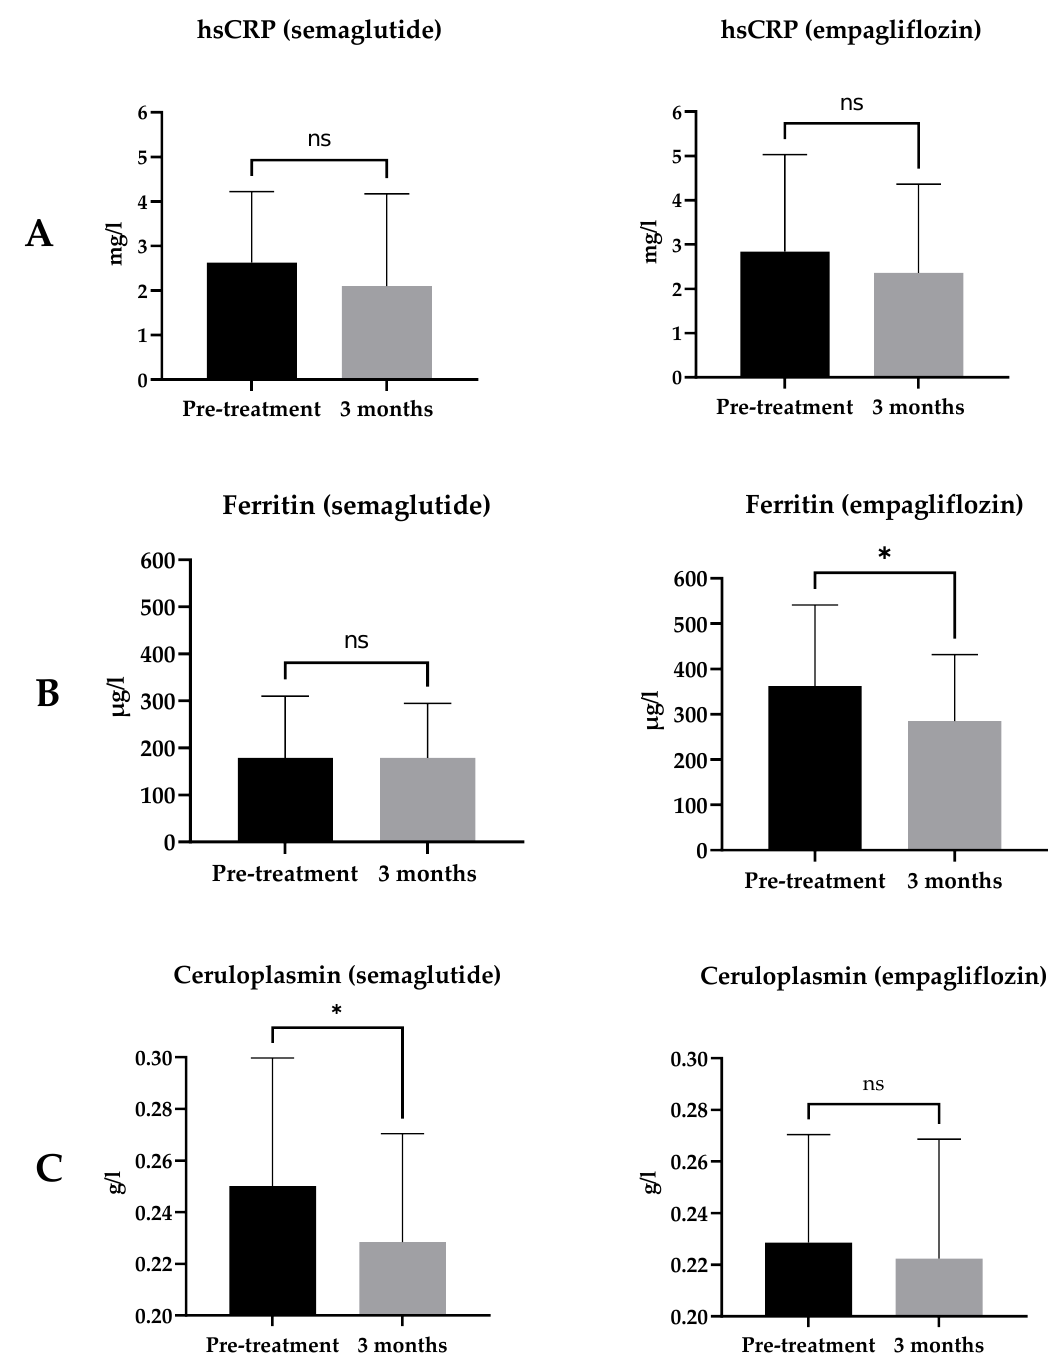
Figure 2. Change in hsCRP ( A ), IL-6 ( B ), ferritin ( C ), and ceruloplasmin ( D ) with 3-month treatment with semaglutide or empagliflozin. Statistics: Paired t -test or Wilcoxon matched-pairs signed rank-test as appropriate; mean ± SD; ns: p ≥ 0.05, * p < 0.05, n = 8.